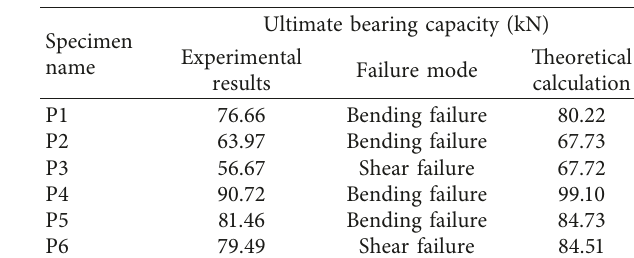
Table 3: Load-carrying capacity of tested